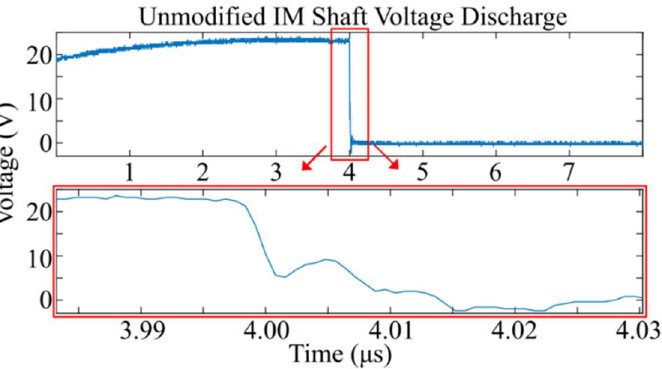
9 of 21 Table 1. Summary of modified IM circuit modeling component values with final values in the “PSpice Optimizer” row. Component